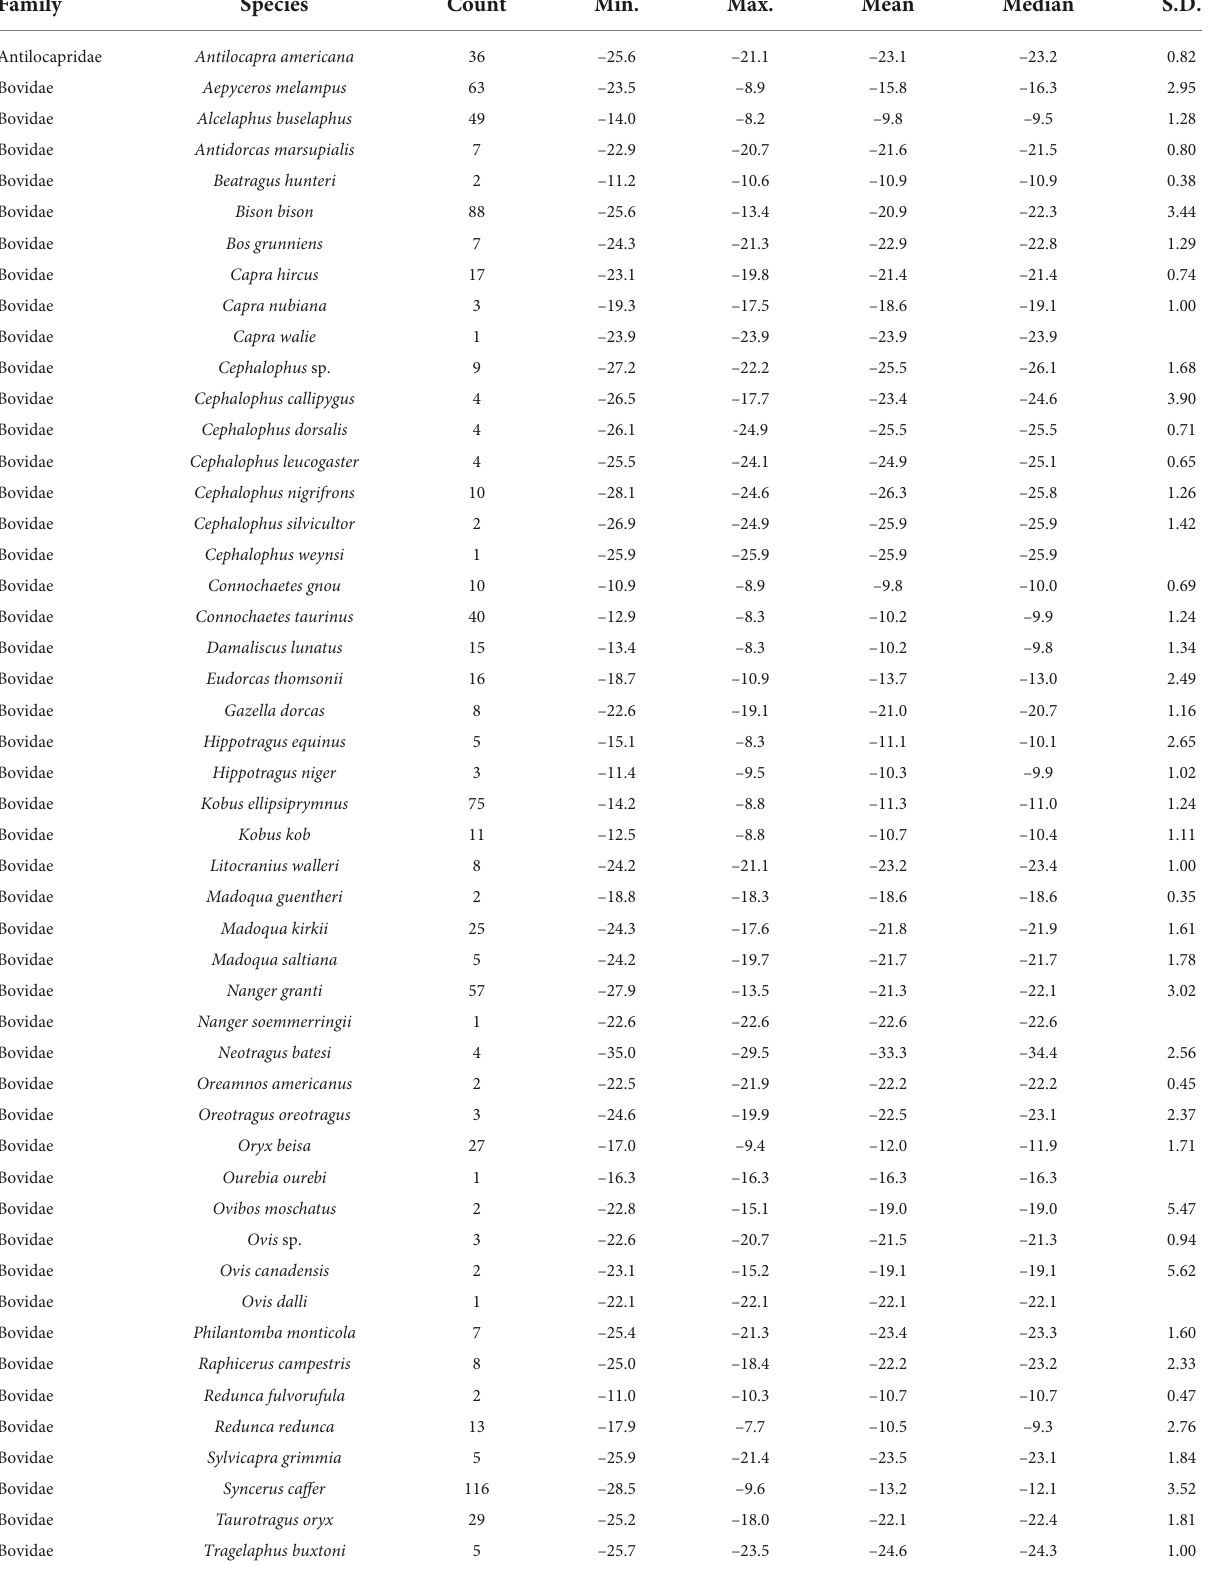
TABLE 2 Summary statistics for calculated δ 13 C diet values of 79 species of artiodactyls documented in this study.